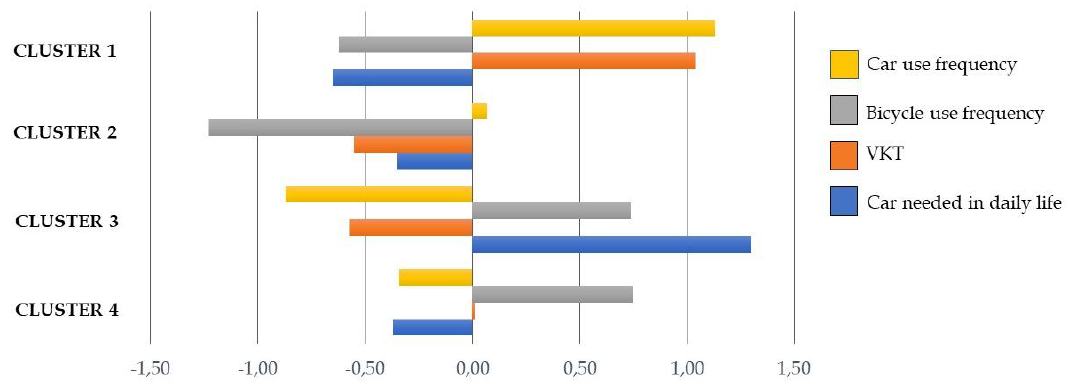
Figure 3: Graphical representation of cluster centres for each constituent variable.